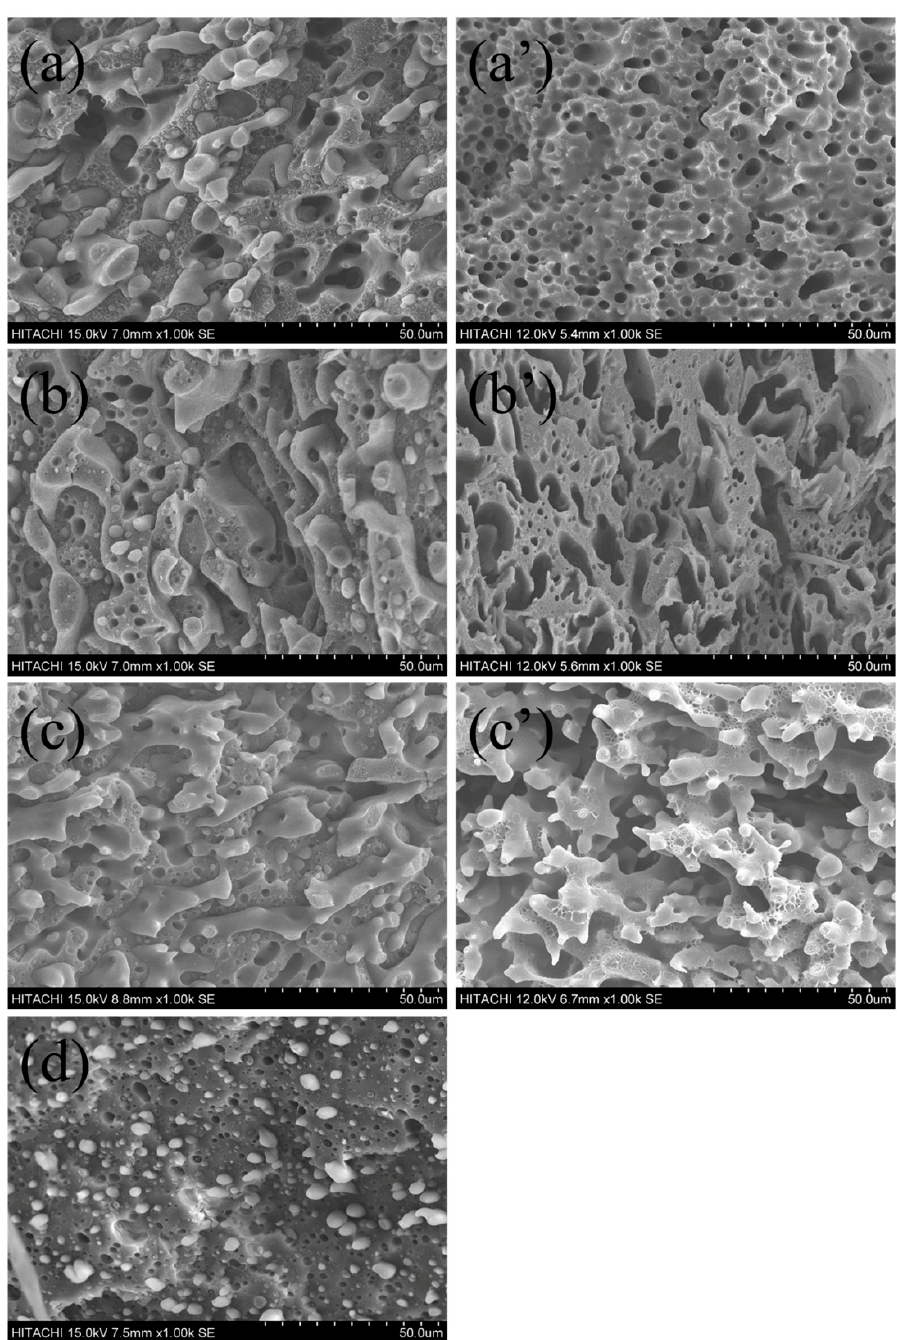
Figure 1. Scanning electron microscope (SEM) of poly (lactic acid) (PLA) / high-density polyethylene (HDPE) ( w/w ) blends, ( a, a’ ) 50/50, ( b, b’ ) 60/40, ( c, c’ ) 70/30, and ( d ) 80/20.